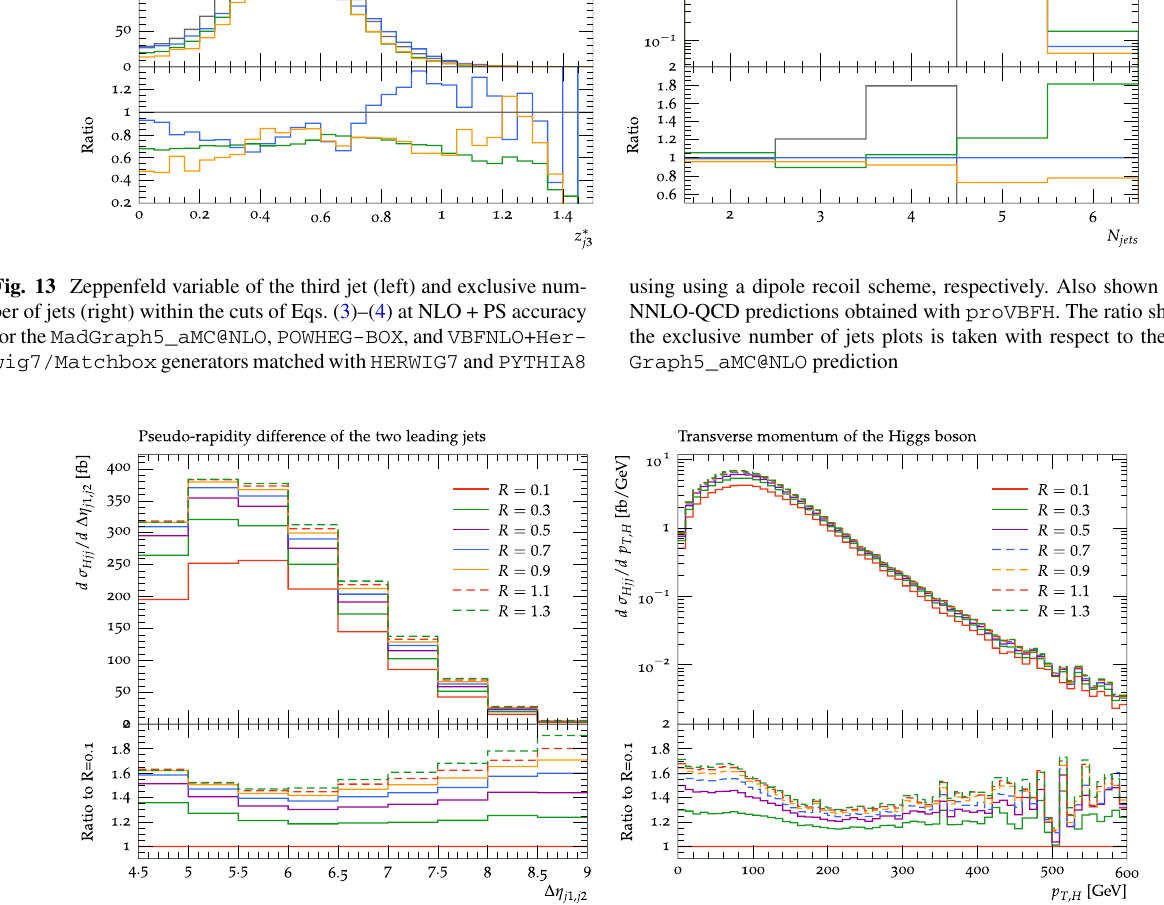
Fig. 14 The jet radius dependence illustrated for the pseudorapidity difference between the tagging jets, and the transverse momentum of the Higgs boson. Inclusive quantities also show a significant dependence on the jet radius due to selection criterion involving